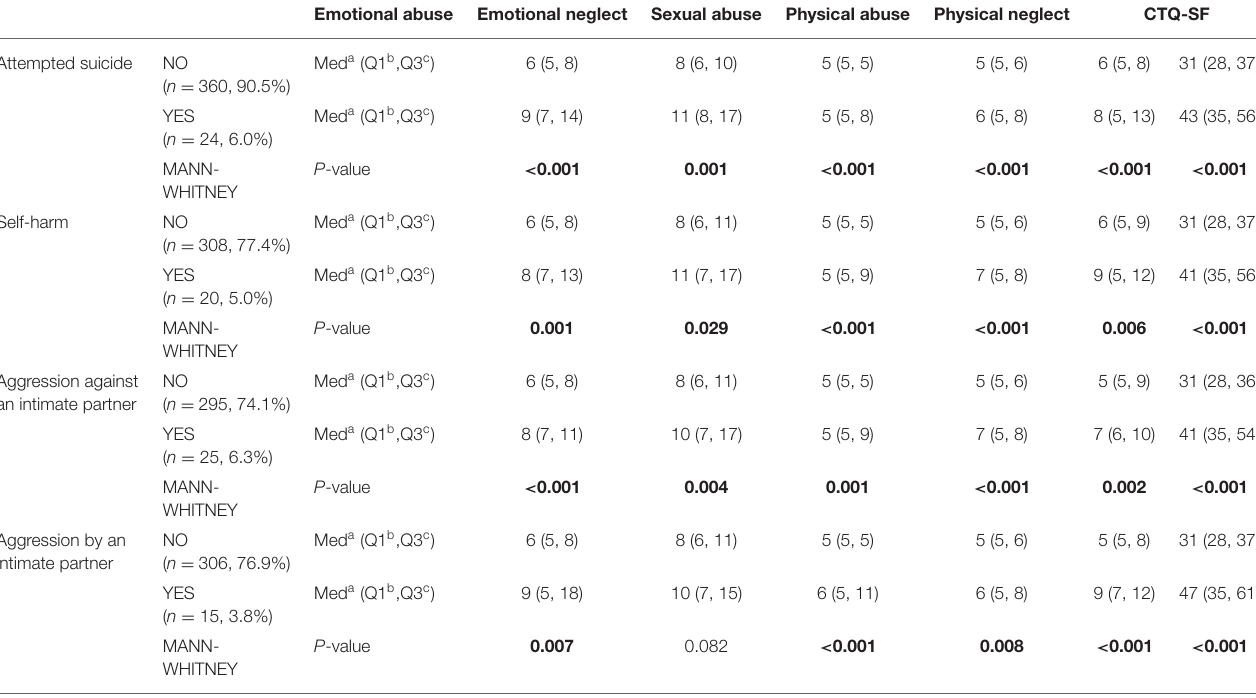
TABLE 5 | Median, interquartile range, and p-value between the different ACE factors, self-harm behaviors, and perpetuation of violence. Emotional abuse Emotional neglect Sexual abuse Physical abuse Physical neglect CTQ-SF Attempted